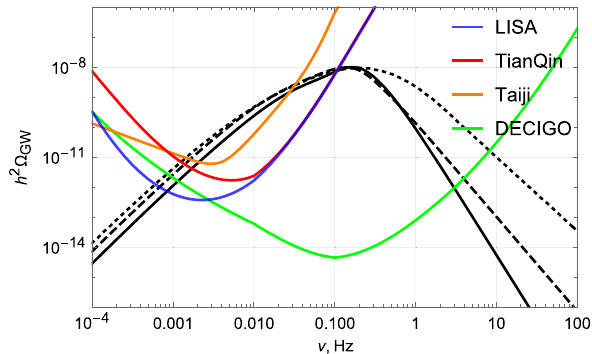
Fig. 13 TheGWdensityfortheparametersetsinTable7:setA(dotted curve), set B (dashed curve) and set C (solid